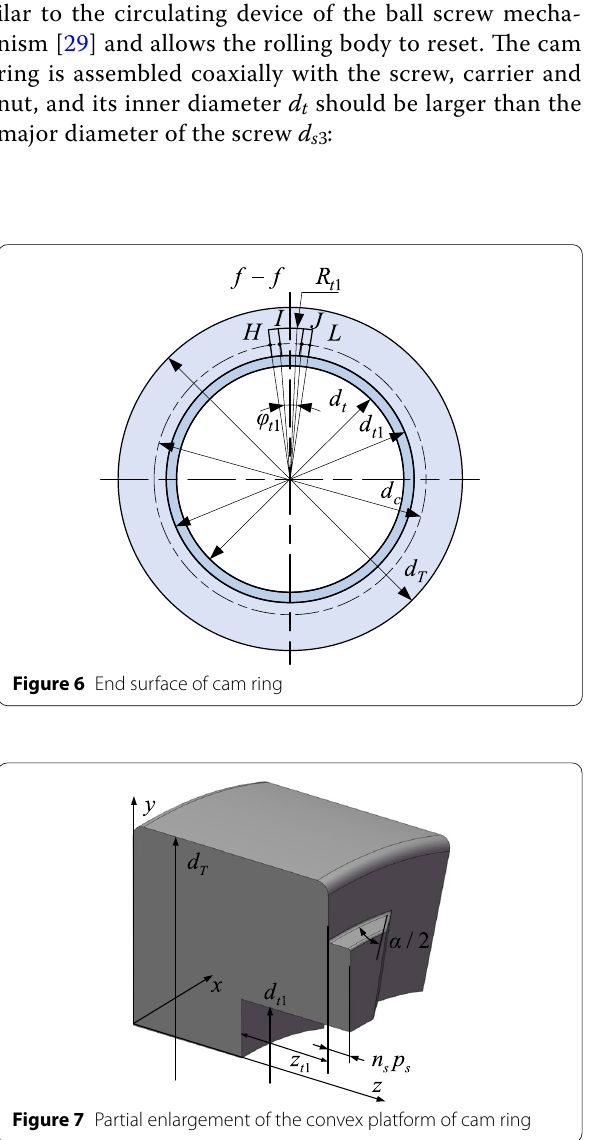
Figure 7 Partial enlargement of the convex platform of cam